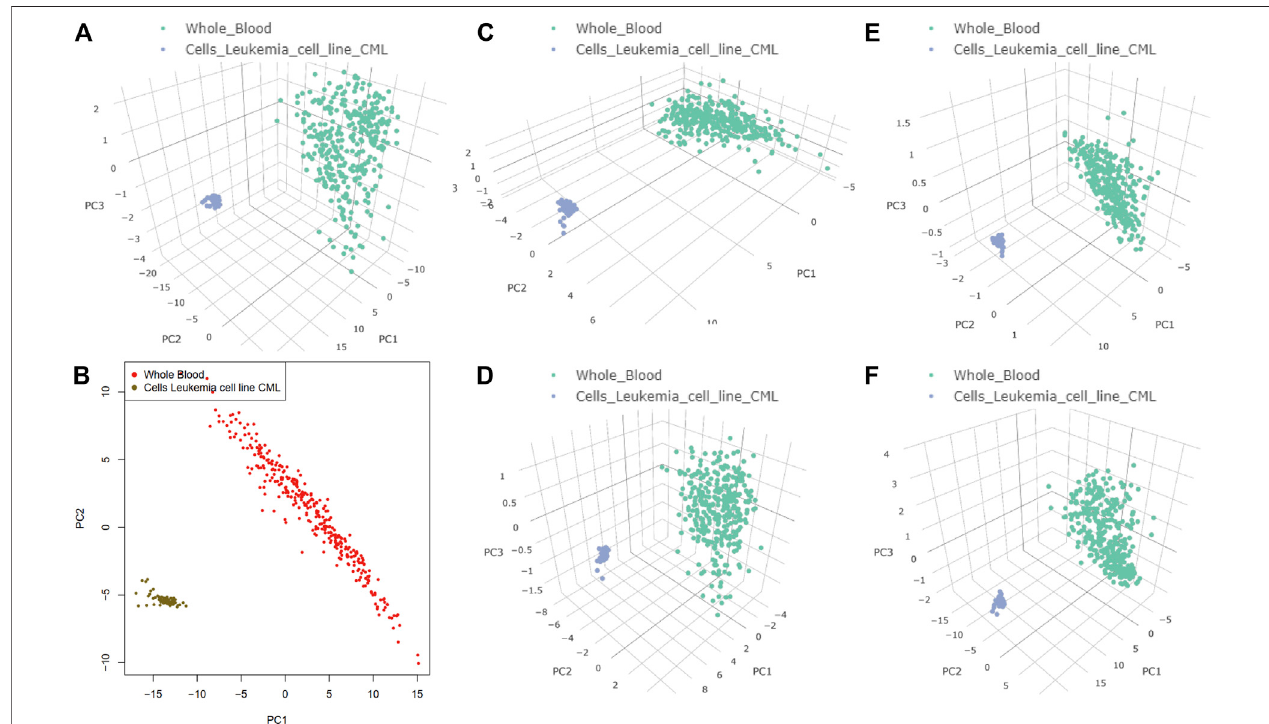
FIGURE 6 | Target genes of the two-layer regulatory networks associated with heterogeneous nuclear ribonucleoprotein K (HNRNPK), heterogeneous nuclear ribonucleoprotein L (HNRNPL), non-POU domain – containing octamer – binding protein, and TAR DNA-binding protein 43 (TARDBP). Principal component analysis dimensionality reduction was performed on the expression datasets of Cells-Leukemia cell line (CML) and Whole Blood. (A) Target genes of the two-layer regulatory networks associated with HNRNPK, HNRNPL, NONO, and TARDBP in 3D. (B) Target genes of the two-layer regulatory networks associated with HNRNPK, HNRNPL, NONO, and TARDBP in 2D. (C) Target genes of the two-layer regulatory networks associated with HNRNPK. (D) Target genes of the two-layer regulatory networksassociatedwithHNRNPL. (E) Targetgenesofthetwo-layerregulatorynetworksassociatedwithNONO. (F) Targetgenesofthetwo-layerregulatorynetworks associated with